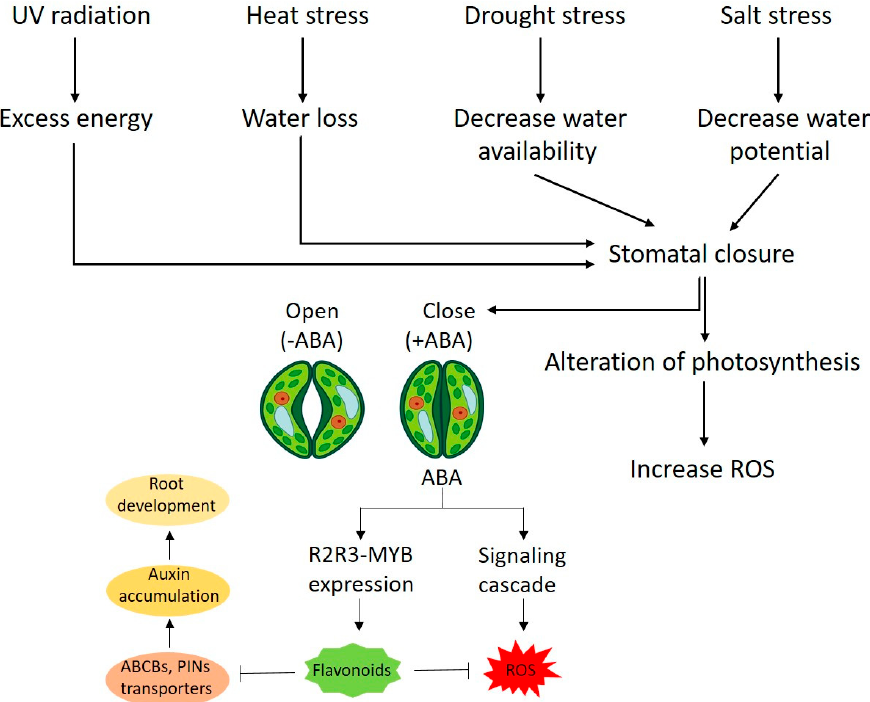
Figure 3. Proposed model indicate schematic representation of plant responses to abiotic stresses mediated via ABA and flavonoid signalling. Mostly, abiotic stress reduces water availability and consequently plant close the stomata and release ABA hormone. Flavonoids (kaempferol, quercetin) act as ROS scavenger and interact with ABA and auxin in leaf and root respectively. Stomatal opening in leaves is permitted by ABA binding to the membrane receptors resulting in ions and water efflux leading to stomata closure. ABA induces R2R3-MYB gene and stimulating flavonoids biosynthesis, which also triggers a signalling cascade which leading to ROS generation. In root, flavonoids reduce auxin transport resulting to auxin accumulation and root development. This model is adopted from Justine Laoué et al., [69].